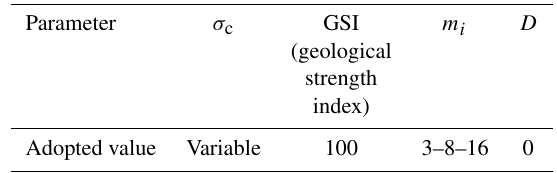
Figure 1. Geometrical parameters of the cavity ( h : cavity height; L : cavity width; t : overburden thickness). Table 1. Values of Hoek–Brown parameters assigned in 2-D analy-